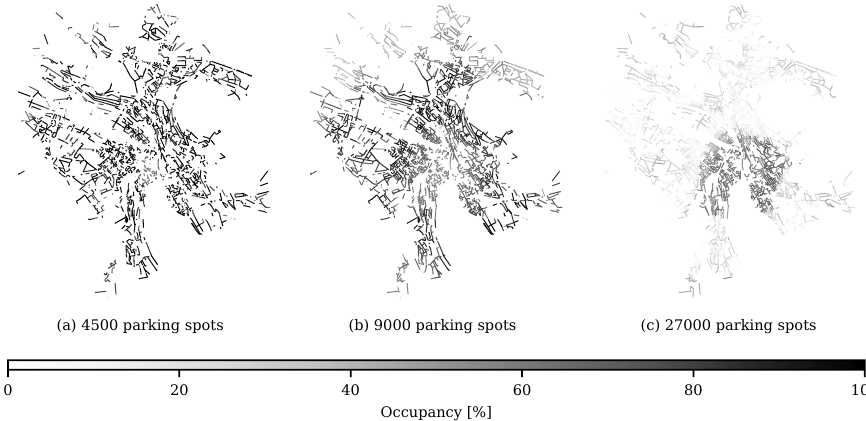
Figure 5. Occupancy of parking spaces for the case of Optimal Flow Parking Assignment and Public parking